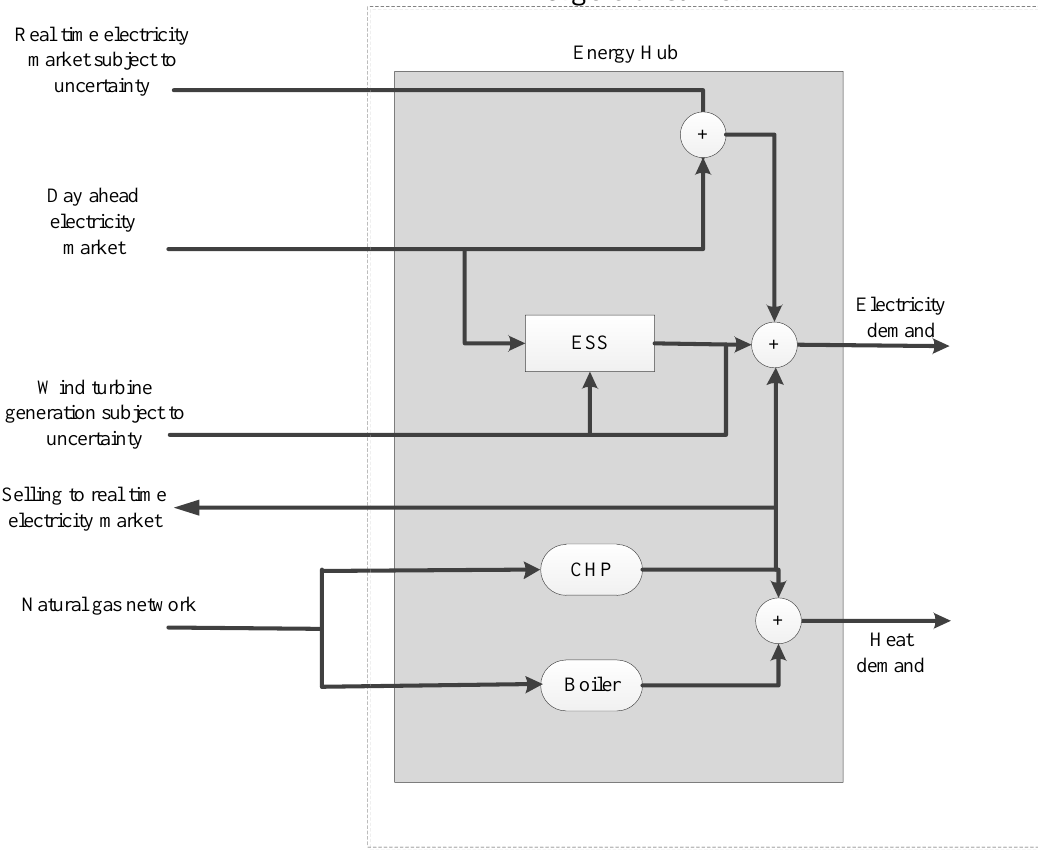
Figure 1. The energy hub under